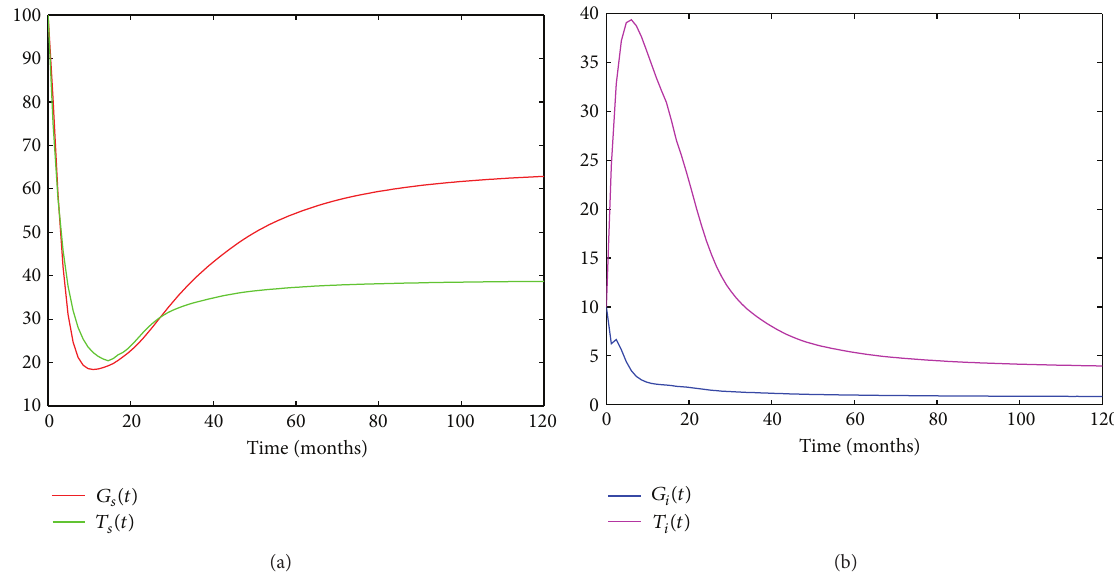
Figure 2: The infection equilibrium 𝐸 ∗ of system (3) is asymptotically stable when 𝜏 = 0 , 𝜔 = 15 , and R 0 > 1 . The initial functions are (100, 10, 100 , and 10)